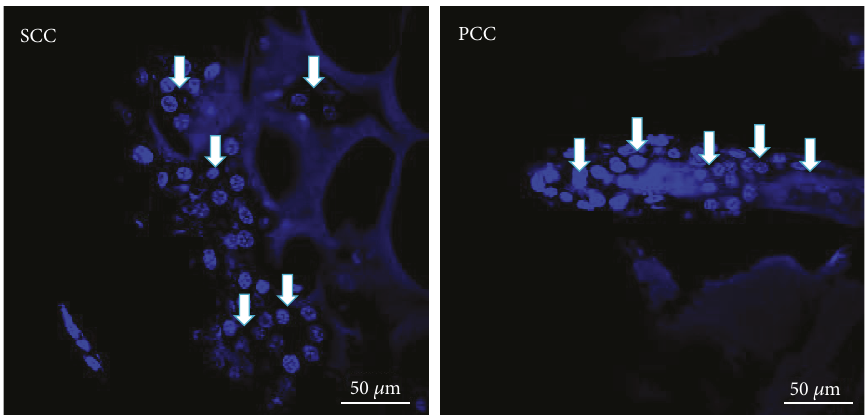
Figure 5: Cells cultured for 5 days on composite membranes were stained with DAPI. As shown in the images, cell number (the cells are indicated by arrows) enhanced in porous chitosan composite (PCC) membranes compared to that in simple chitosan composite